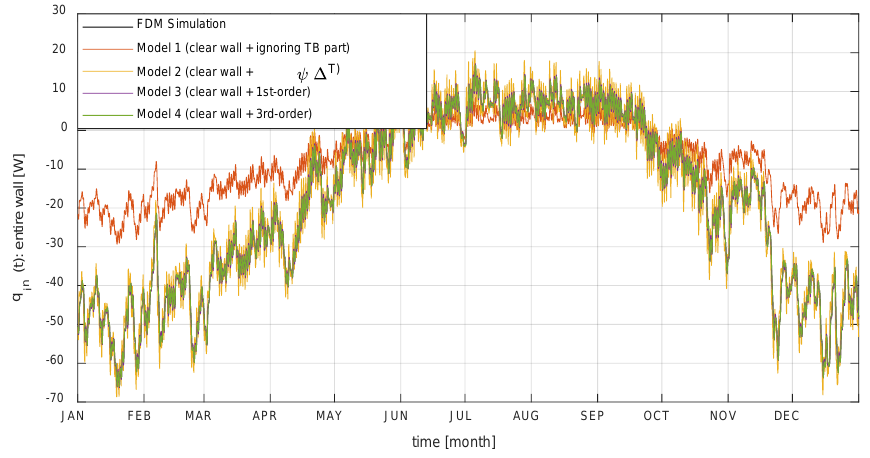
Figure 13. Heat flow through the entire wall (one year).